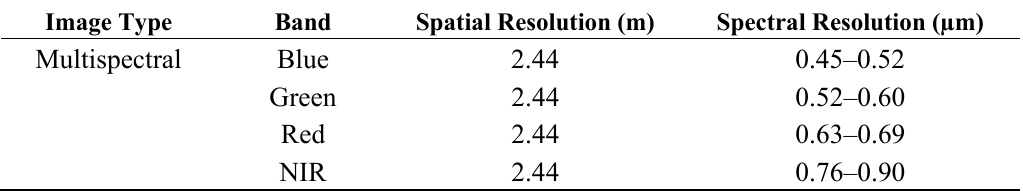
Table 1. Spatial and spectral resolution of the QuickBird